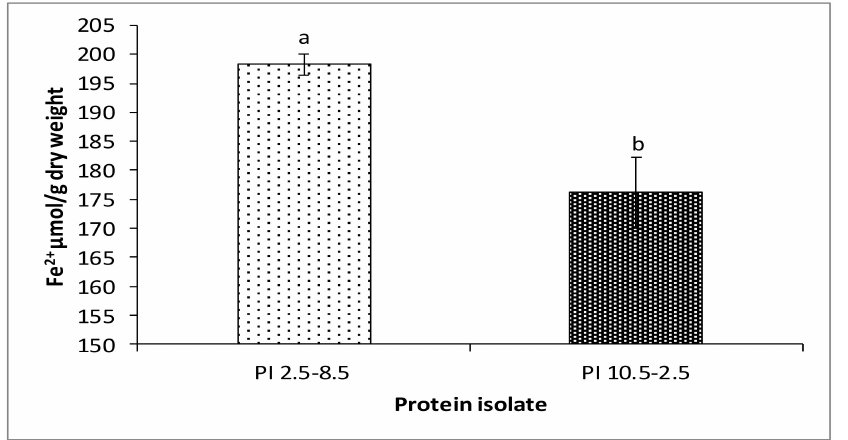
Figure 6. Ferric reducing antioxidant power (FRAP) of ethanol-treated rapeseed meal protein isolates, PI 2.5–8.5 and PI 10.5–2.5 . a,b Means with different superscripts differ significantly ( p < 0.05). Proteins, which are major constituents of PI 2.5–8.5 and PI 10.5–2.5 , are also excluded